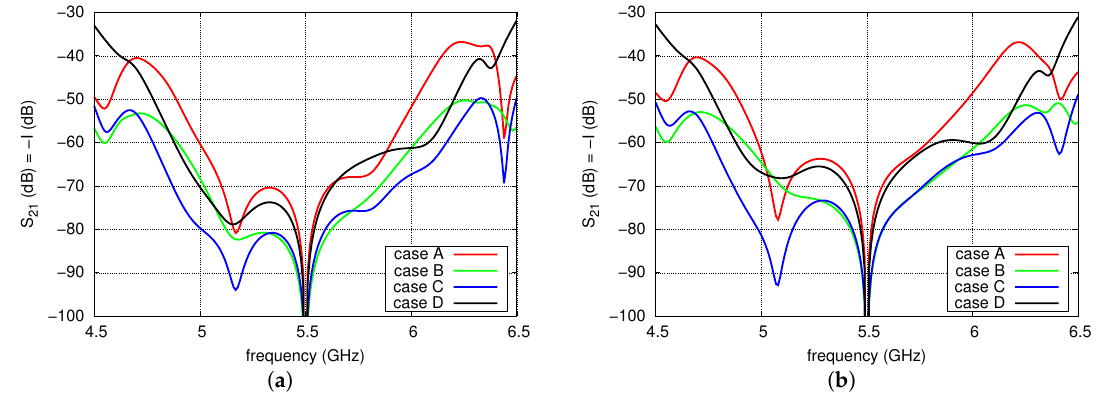
Figure 10. Isolation versus frequency for: ( a ) d = 35 mm; ( b ) d = 40